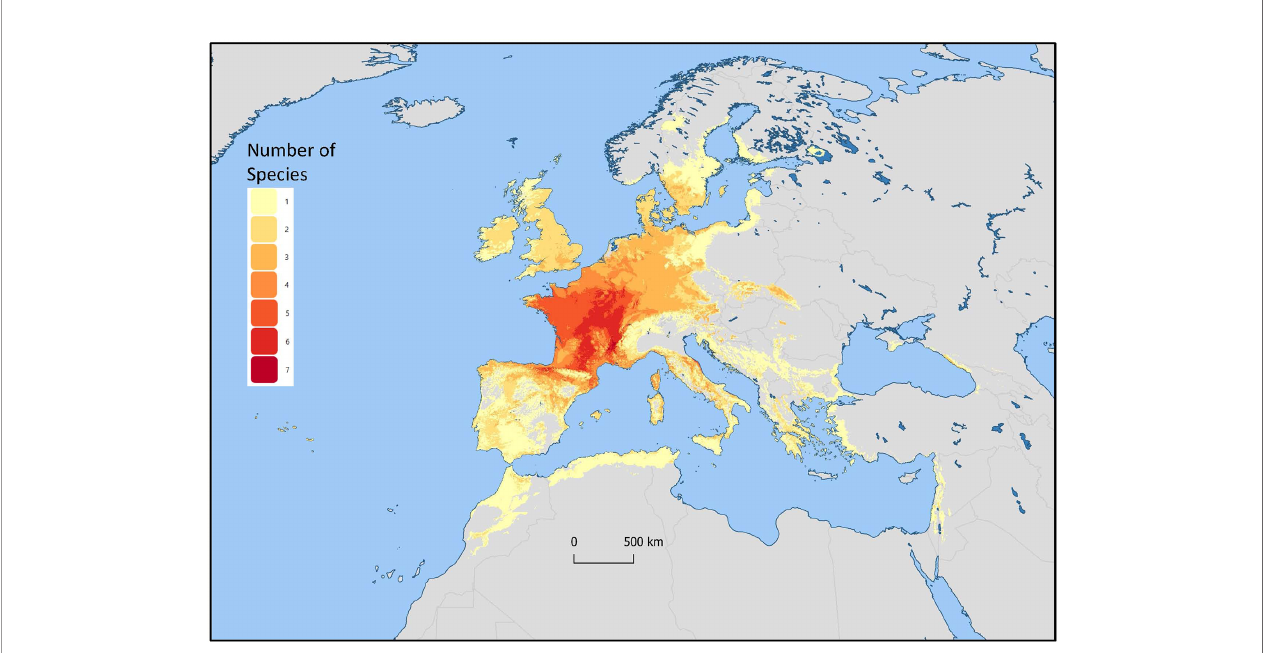
FIGURE 2 | Global richness map for 17 endemic Mentha L. species. The colors indicate the number of species in that